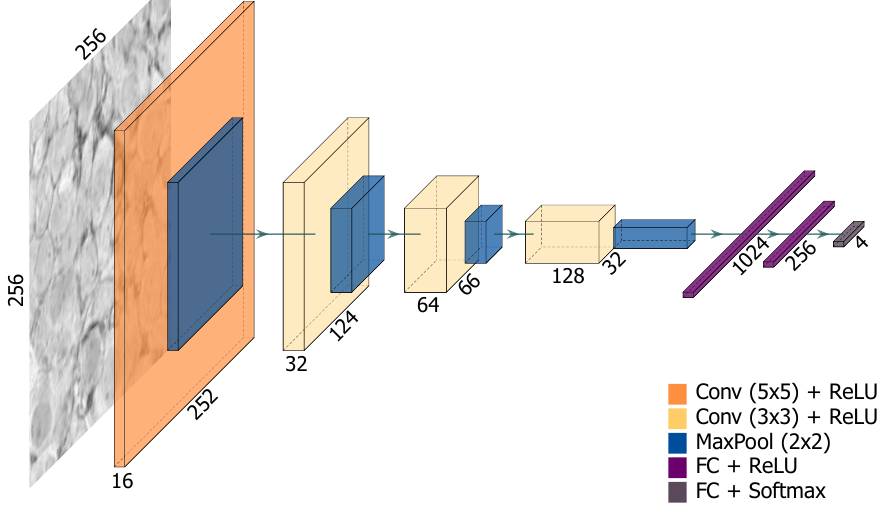
Figure 5. Architecture of the implemented convolutional neural